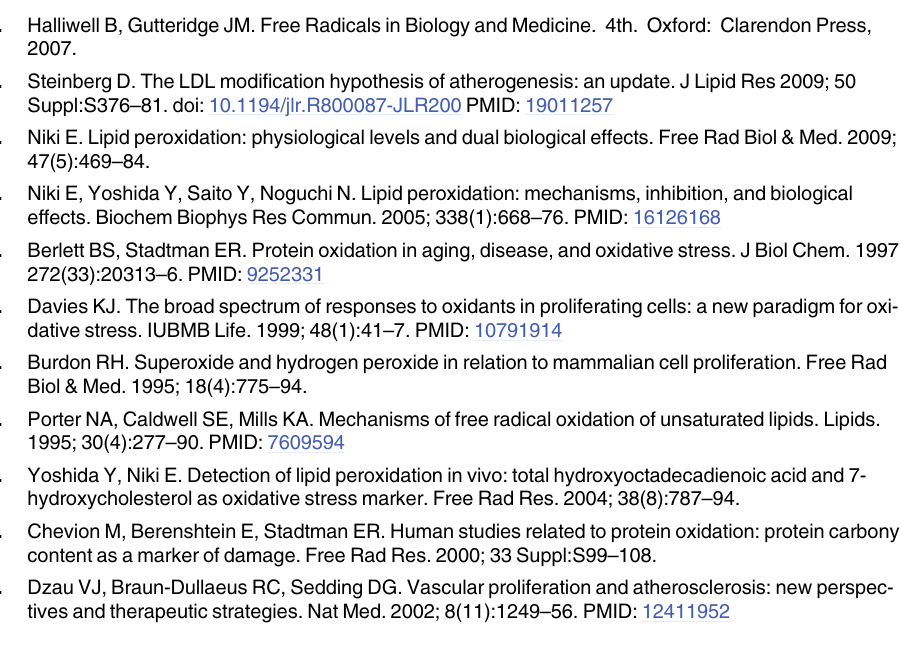
S1 Fig. Effects of hydrogen peroxide on the viability of vessel cells. HUVEC was treated with O ) for 48h, and the viability was measured variable concentrations of hydrogen peroxide (H 2 2 by WST assay. (cid:1) P < 0.01, compared with vehicle control. S2 Fig. Effects of cumene hydroperoxide on the viability of vessel cells. HUVEC was treated with variable concentrations of cumene hydroperoxide (Cumene-OOH) for 48h, and the via- bility was measured by WST assay. (cid:1) P < 0.01, compared with vehicle